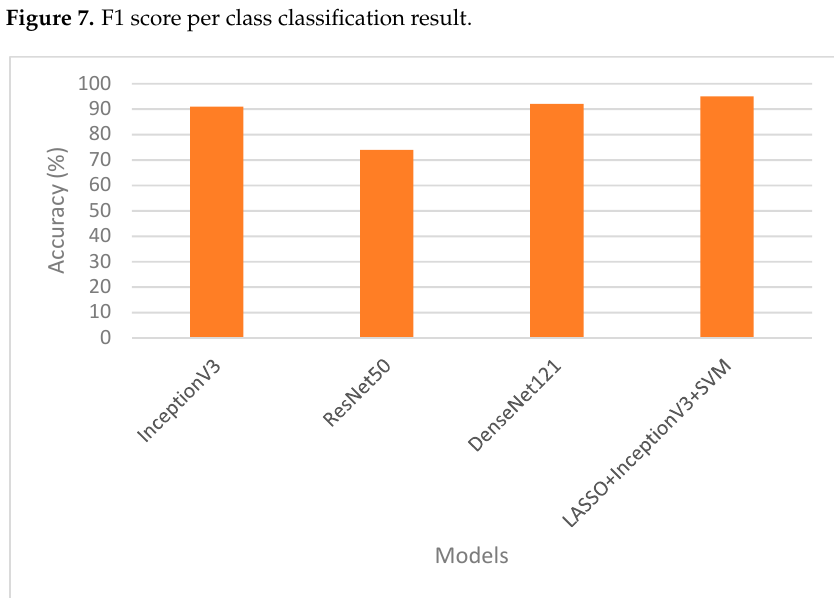
Figure 8. Accuracy Per Class Classification Result .